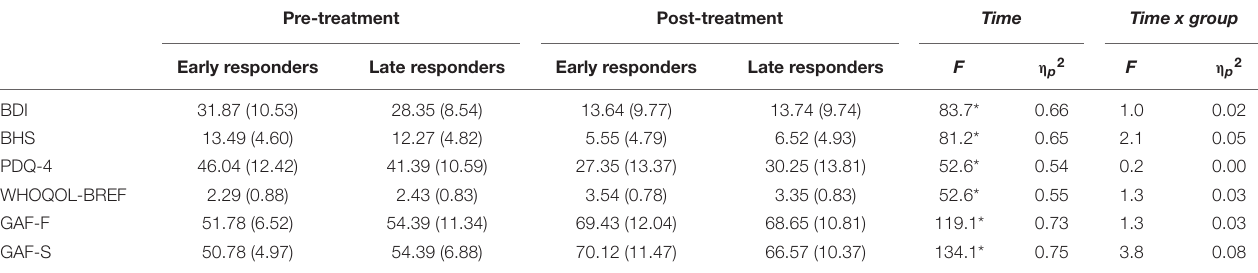
TABLE 2 | Means and standard deviations for BDI, BHS, PDQ-4, WHOQOL-BREF, and GAF before and after treatment. Pre-treatment